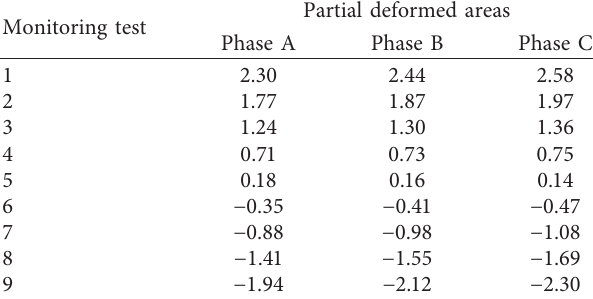
Table 1: Monitoring instructions for deformed